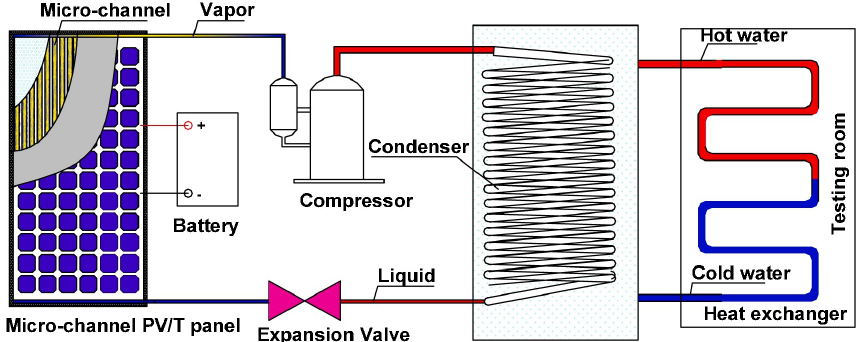
Figure 15. Solar driven direct-expansion heat pump system employing the novel PV/minichannels- evaporator modules